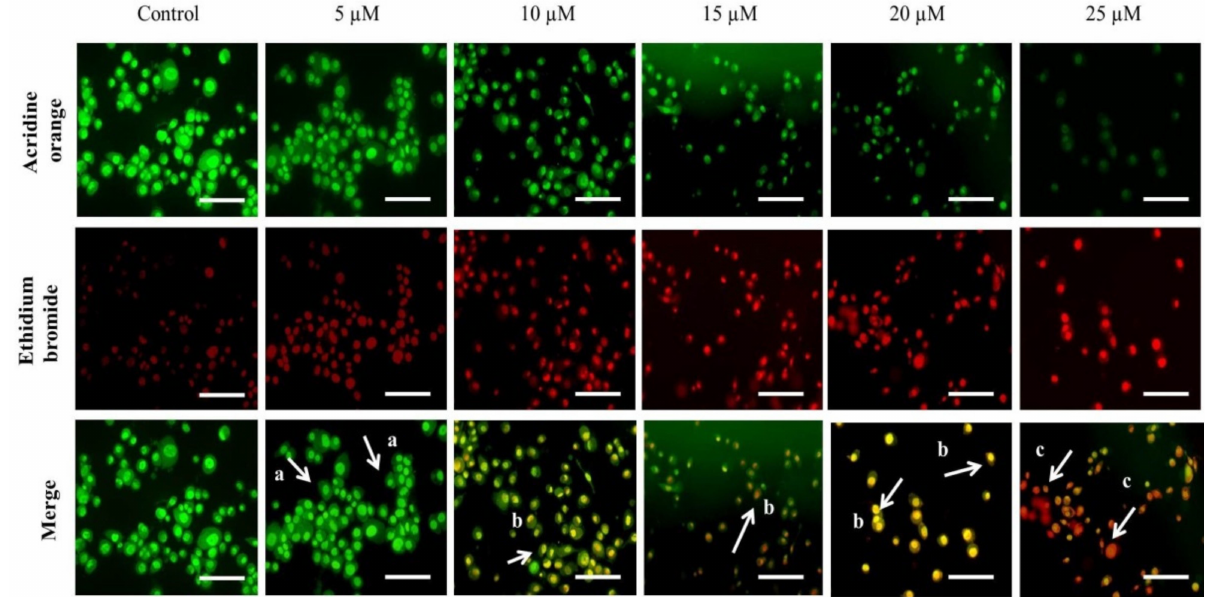
Figure 4. Instigation of apoptosis in PC-3 cells post treatment with stated Cur-B concentration as assessed through AO/EtBr dual staining. Scale bar = 100 µ m; a, b and c represent viable, early apoptotic and late apoptotic PC-3 cells,